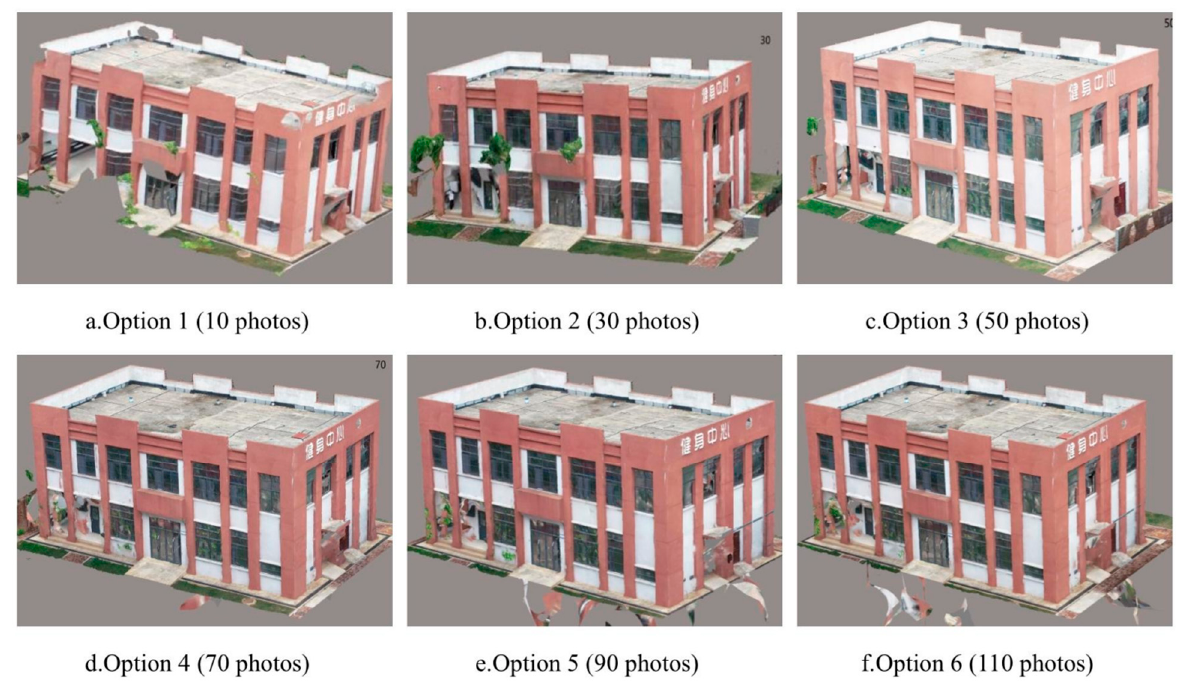
Figure 3. 3D model of each scheme. In this process, the next photo memory (indicator C1 ), model memory (indicator C2 ) and internal processing time (indicator C4 ) are recorded, the three indicators